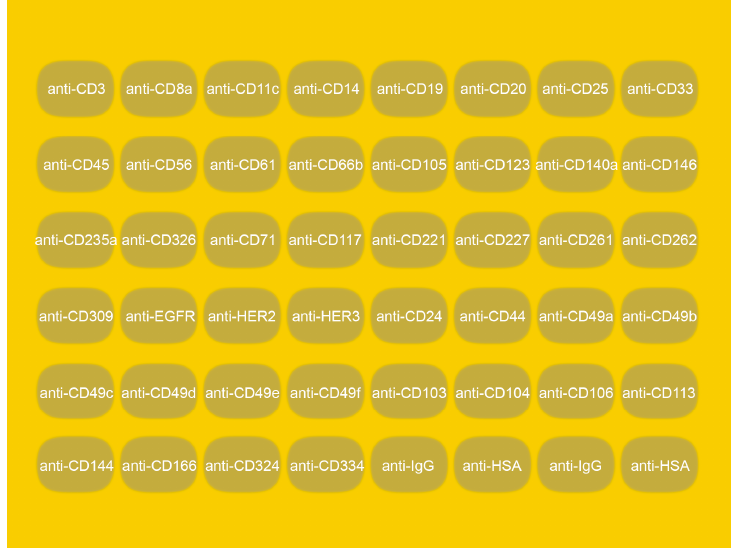
Figure 1. Schematic image of the 44 parameter Surface Plasmon Resonance imaging (SPRi) sensor. The 6 × 8 printhead created 48 spots with dimensions of 500 × 830 µm 2 in a Surface Plasmon Resonance × 8 printhead created 48 spots with dimensions of 500 × 830 µ m 2 in a Surface Plasmon Resonance (SPR) image area of 6 × 8 mm. 6 (SPR) image area of 6 × 8